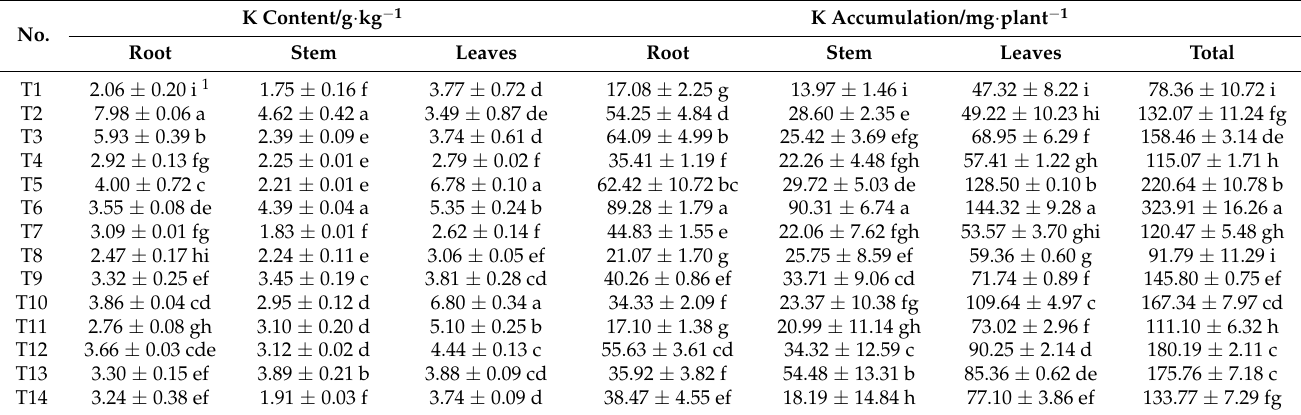
Table 7. K content and accumulation of P. bournei seedlings under different N-P-K fertilization.